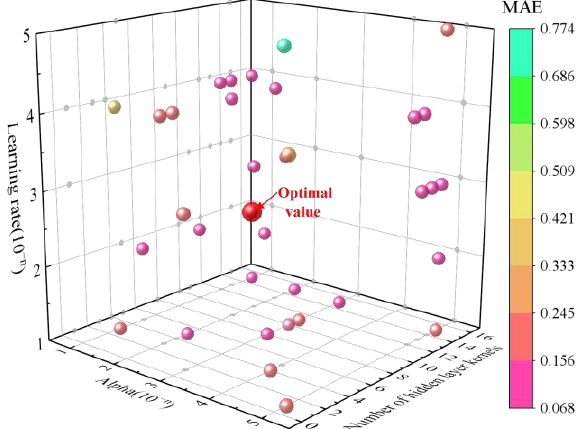
Figure 11. Process for optimizing MLP hyperparameters.